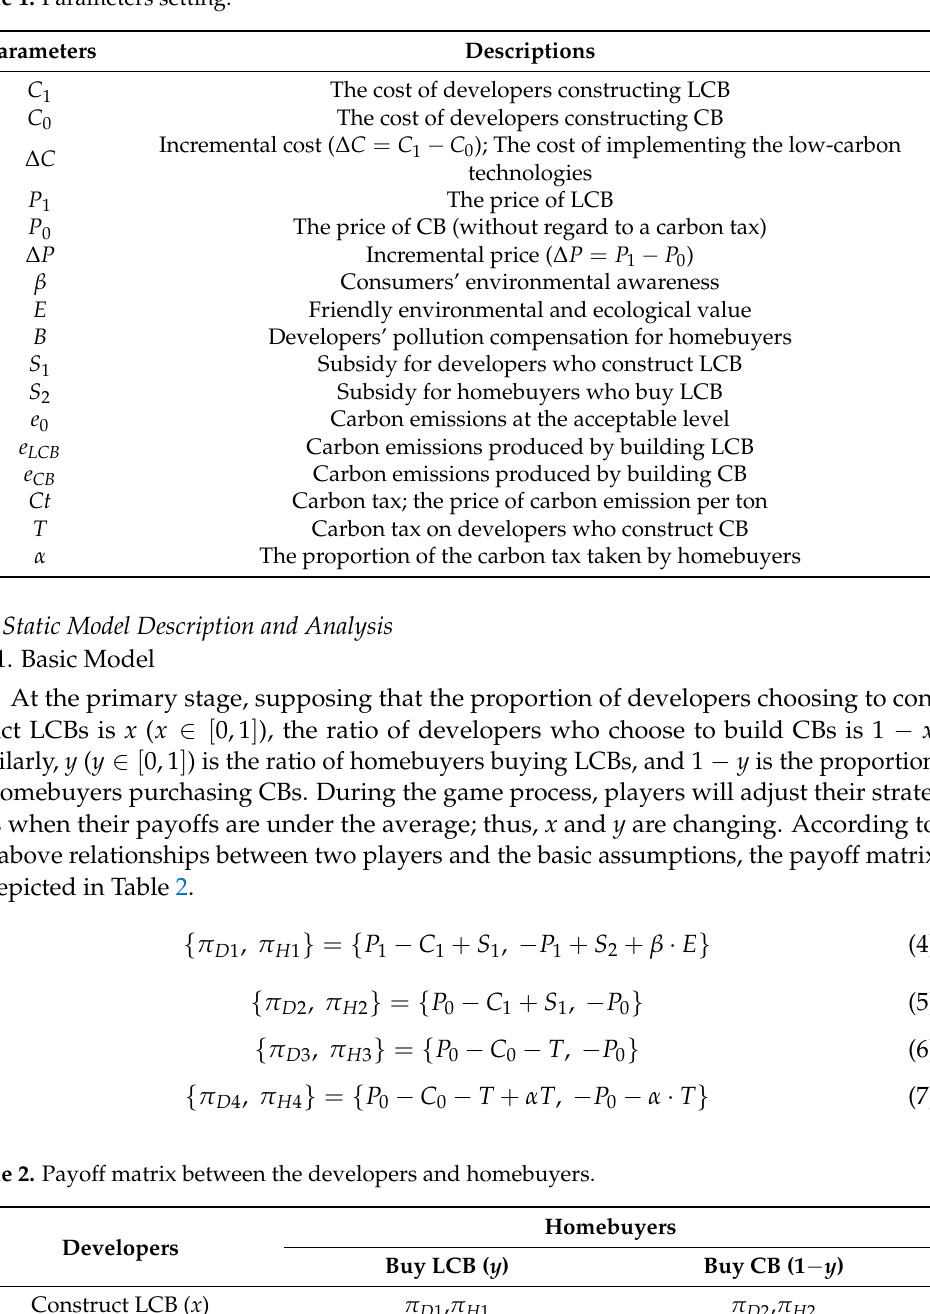
Table 1. Parameters setting.